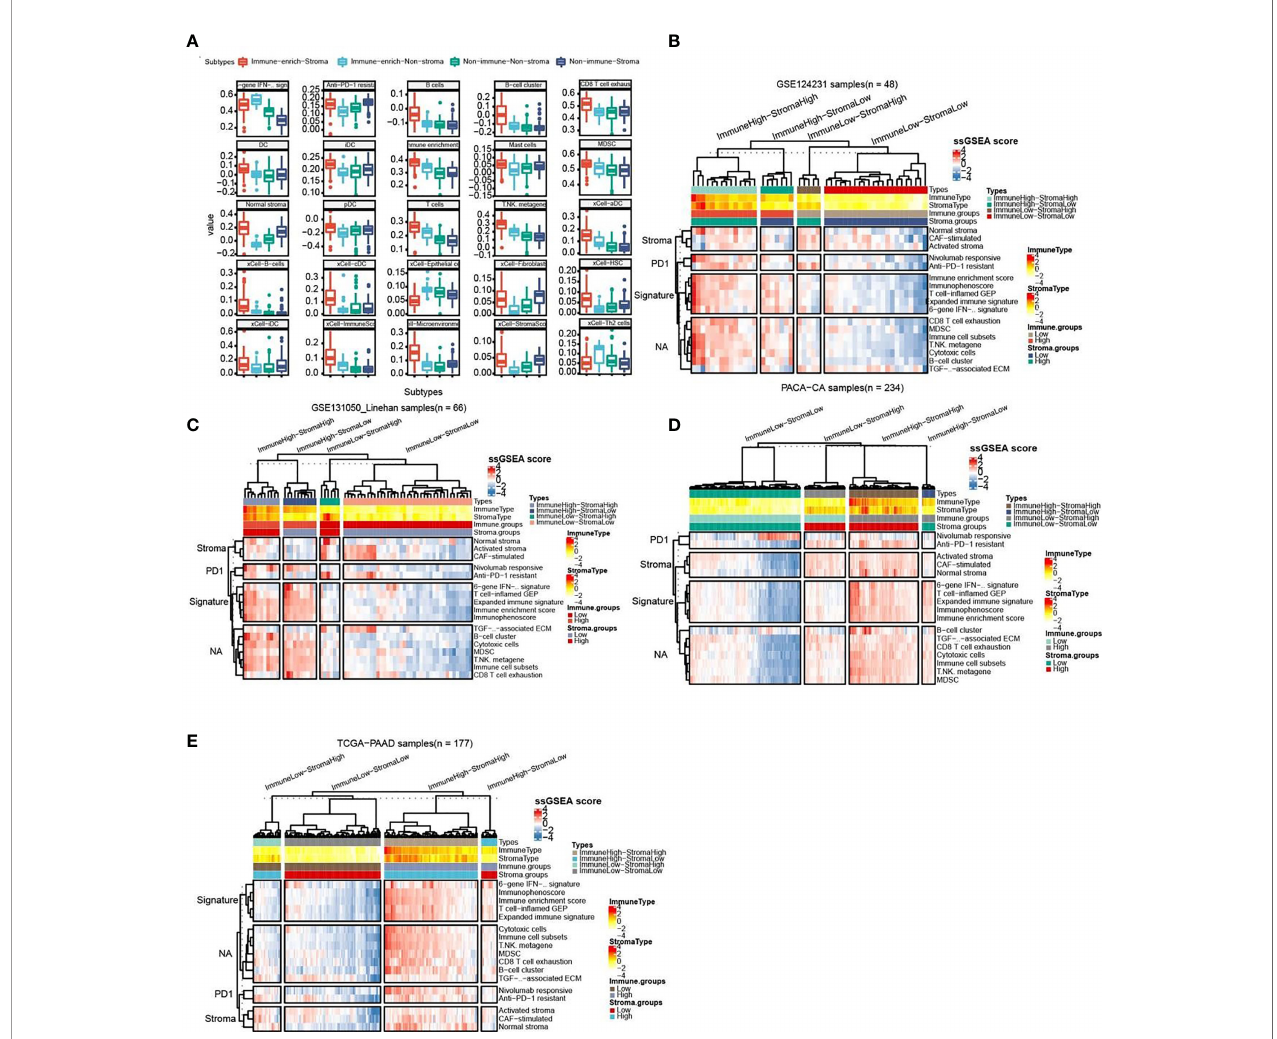
FIGURE 2 | Comparison of the striking differences in the immune microenvironment of the four subtypes. (A) Comparison of the striking differences in the immune microenvironment of the four subtypes. Red represents immune-enrich-stroma subtype, Light_blue represents immune-enrich-non-stroma subtype, Green represents non-immune-non-stroma subtype, and Navy blue represents non-immune-stroma subtype. (B) Immune-enrich-Stroma, Immune-enrich-non-Stroma, Non- immune-Stroma and Non-immune-non-Stroma types in the GSE124231 data set (n=48). (C) Four types in the GSE131050 data set (n=66). (D) Four types in the PACA-CA data set (n=234). (E) Four types in the TCGA-PAAD database (n =